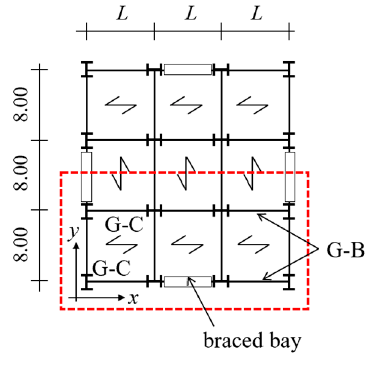
Figure 1. Layout of the considered structures.